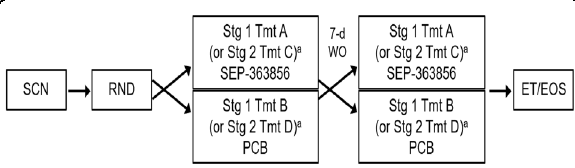
Fig. 1 Study fl ow chart. d day, EOS end of study, ET early termination, PCB placebo, RND randomization, SCN screening, Stg stage, Tmt treatment, V visit, WO washout. a Stage 1 (Group 1) preceded Stage 2 (Group